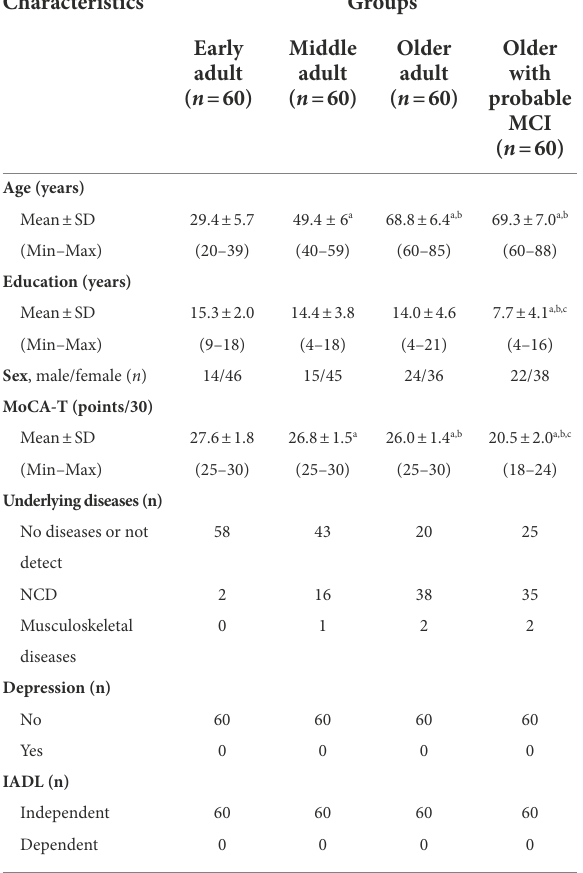
TABLE 1 Participants’